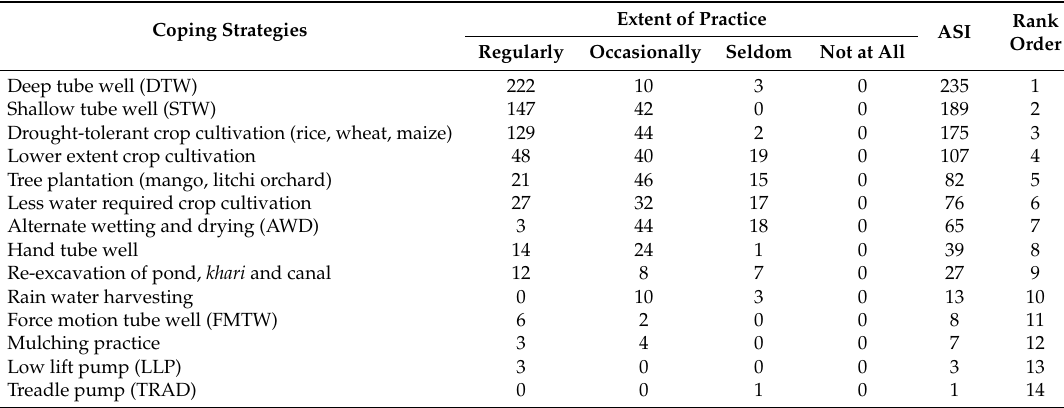
Table 3. Rank order of the coping strategies based on the extent of practice ( n = 100). Coping Strategies